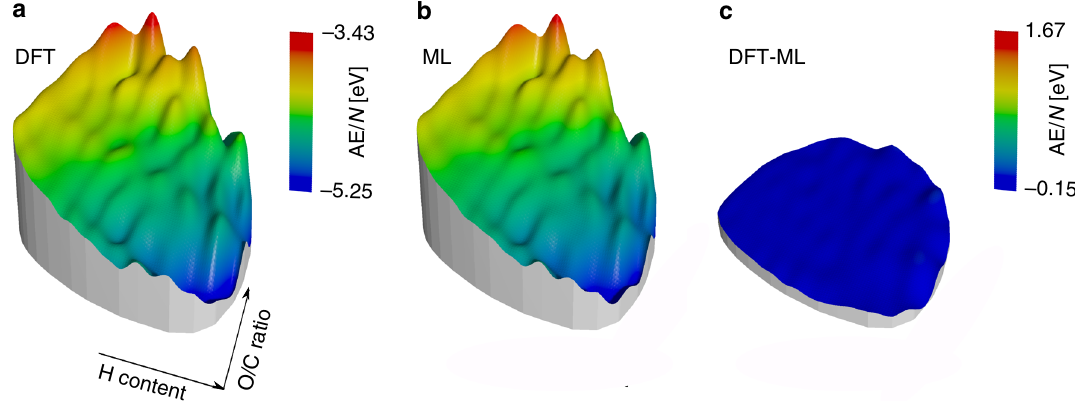
Fig. 5 Illustration of the Rad-6 chemical space as an interpolated height pro fi le. a kPCA as in Fig. 3 showing the DFT reference intensive atomization energies AE/ N (in eV). b Prediction from the ML model using an intensive kernel and a small intensively selected training set of only 1000 molecules with UFF geometries. c Respective differences (DFT-ML). Here, the range of the colorbar is shifted but the scale is the same.